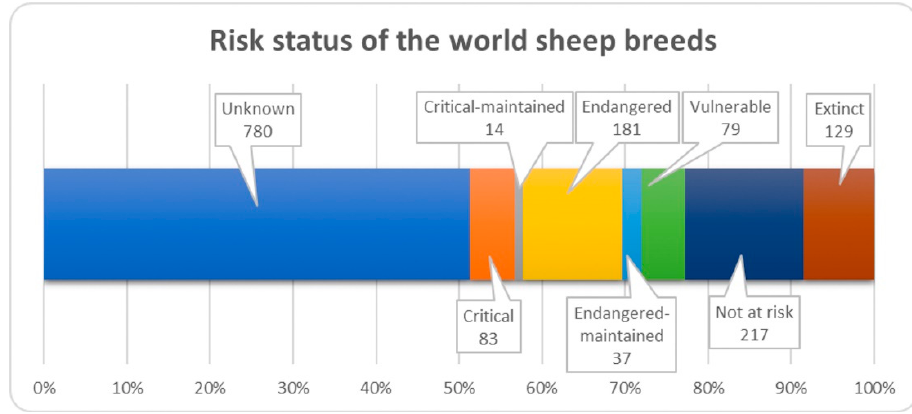
Figure 8. Risk status of the world sheep breeds.